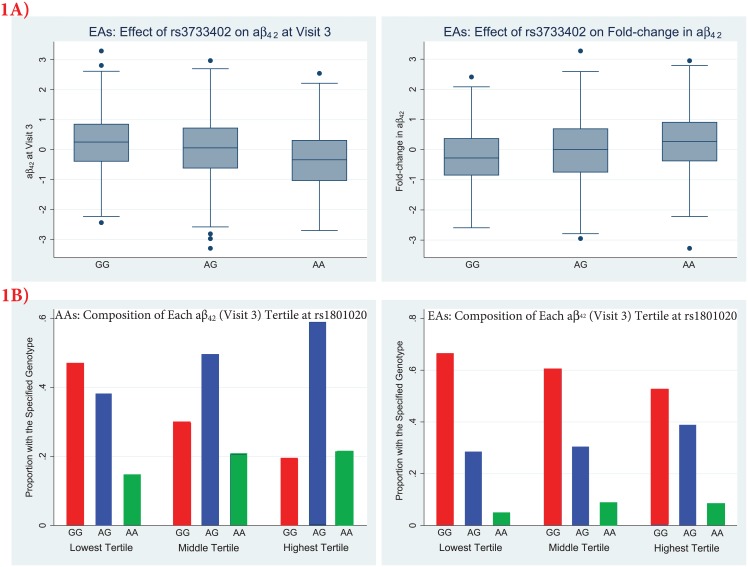
KLKB1 and F12 single-variant associations in ARIC participants with exome sequence. Panel A shows boxplots of the third visit aβ42 levels and the fold-changes in aβ42 stratified by the rs3733402 genotype in EAs. Panel B depicts the relative frequencies of the rs1801020 genotypes within each aβ42 (visit 3) tertile in AAs and EAs. The plotted values are inverse normal transformed amyloid values adjusted for age, gender, time between visits (fold-change aβ42 only), and APOE ε4 carriage status.